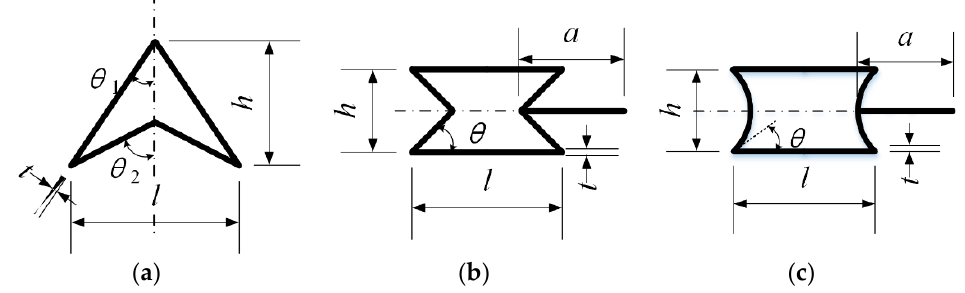
Figure 1. Cross-section of different unit cell. ( a ) Arrow; ( b ) Concave hexagon; and ( c ) Concave arc.